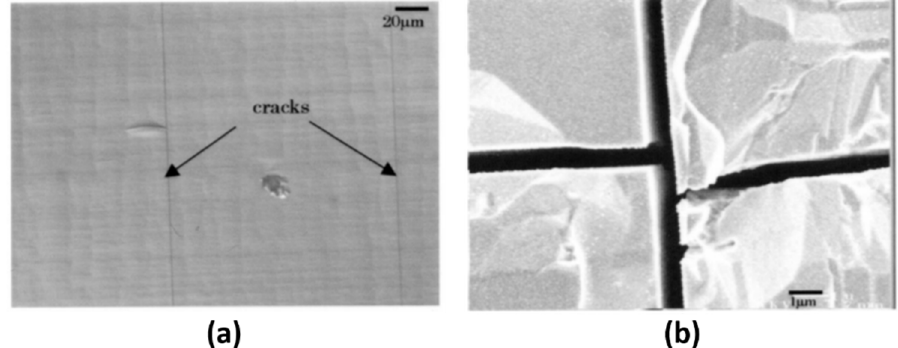
Figure 2. Optical micrographs of thermal cracks formed on GaAs / Si samples ( a ) with 3.8 µ m-thick GaAs layer; ( b ) with 8.1 µ m-thick GaAs layer. Reprinted with permission from Reference [98] © 2003 American Institute of Physics.